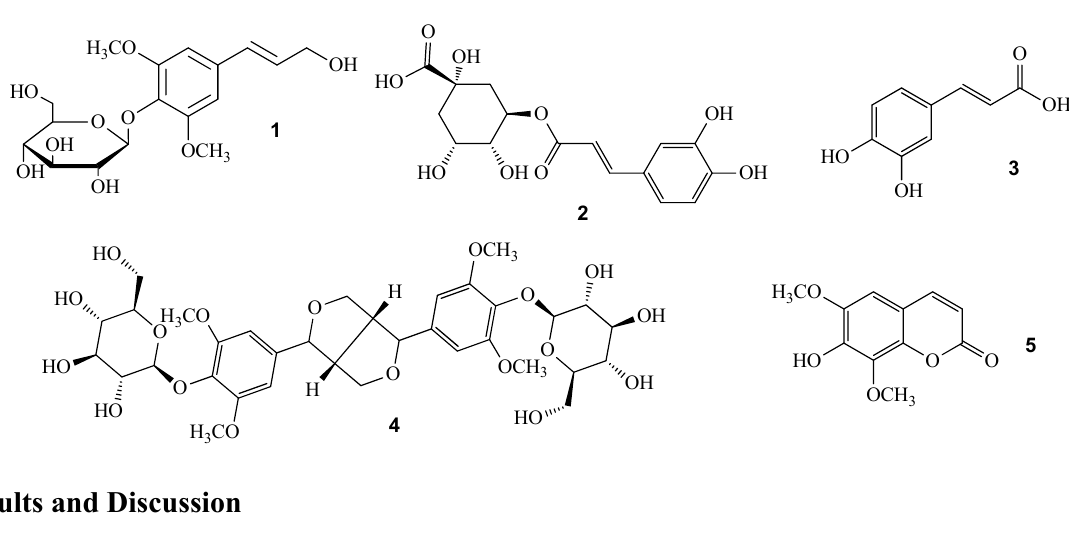
Figure 1. Structures of syringing ( 1 ), chlorogenic acid ( 2 ), caffeic acid ( 3 ), eleutheroside E ( 4 ) and isofraxidin ( 5